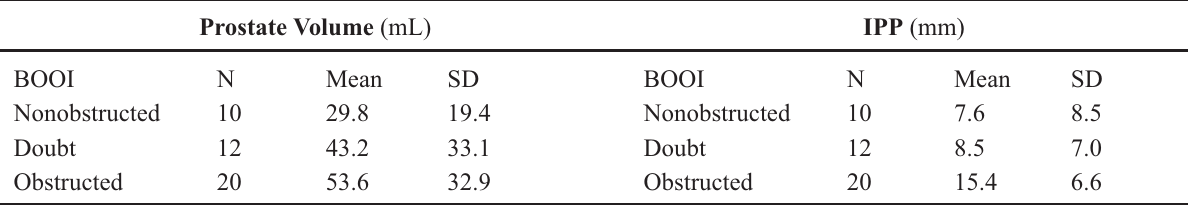
Table 2 – Prostate volume, IPP and BOOI (Kruskal–Wallis; Dunn’s